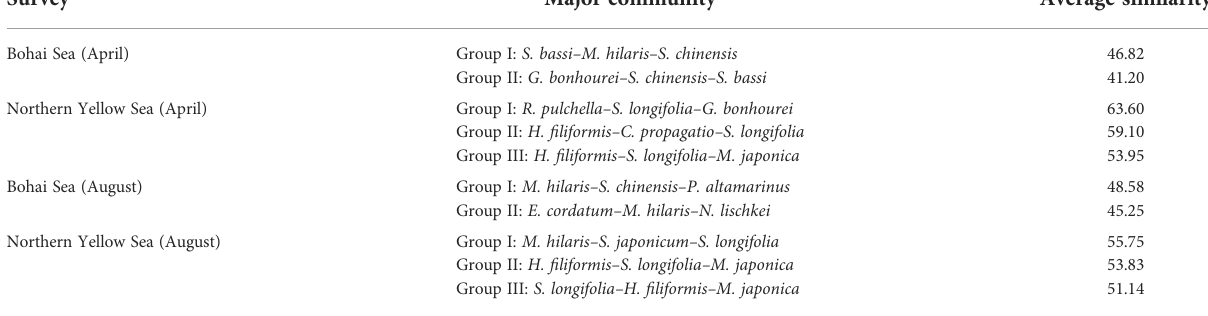
TABLE 3 Macrobenthic community composition in the Bohai Sea and northern Yellow Sea areas off Yantai, China, during the two survey months (April and August).